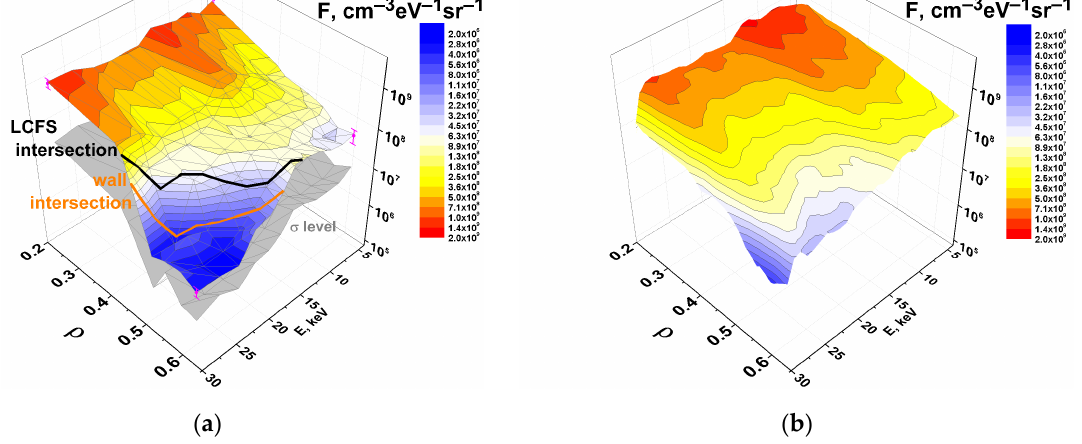
Figure 11. Experimental energy and spatial distribution of the fast deuterium, reconstructed using expression 9 ( a ) (discharges ##39001, 39006-9, 39013, 39015 with similar parameters; energy spectra were measured at different spatial locations from discharge to discharge) and simulated with NUBEAM ( b ). Grey surface shows standard error level. Magenta error bars show epistemic uncertainty. Black and orange lines indicate the borders below which the ion orbits intersect the LFCS and tokamak wall, respectively. The figure is taken from [30] and reproduced with permission from IOP Publishing.